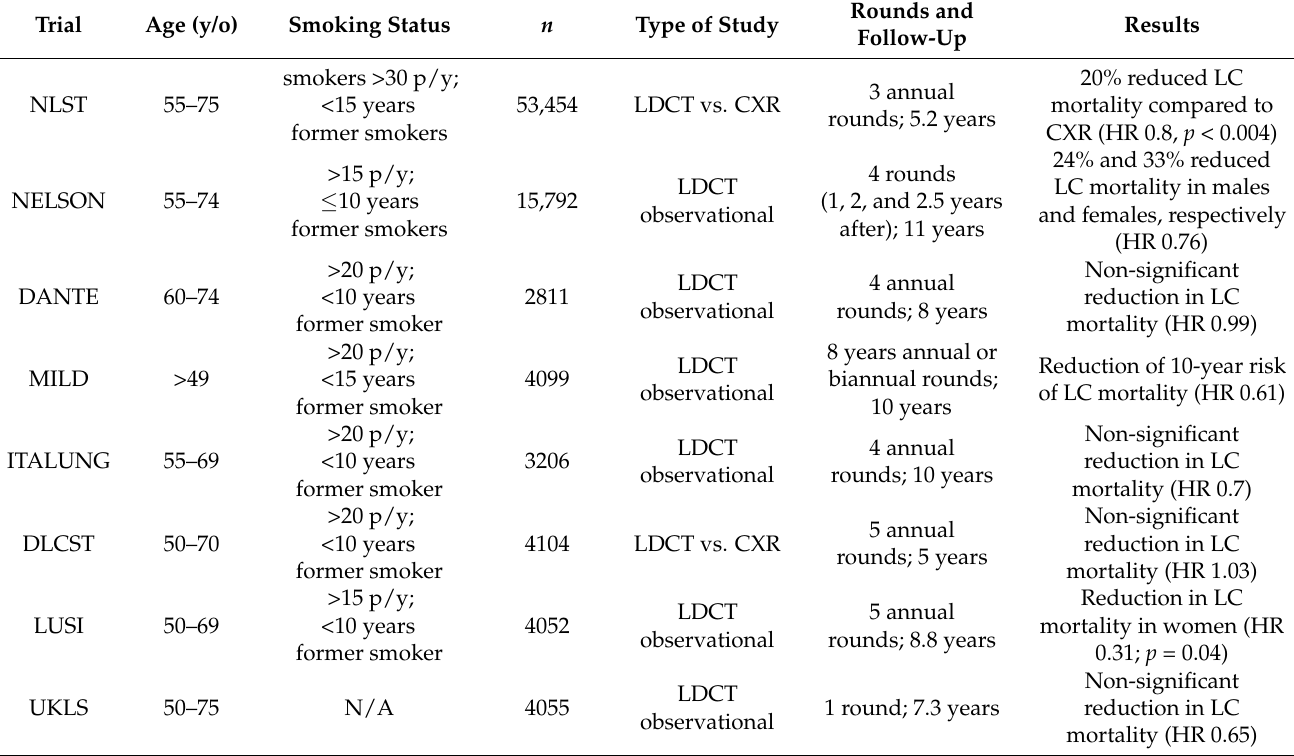
Table 1. Eligibility criteria, number of participants, type of study, and results of the main randomized clinical trials on lung cancer screening. NLST and NELSON trials are the only powered studies. Pooled results of MILD and DANTE show 17% LC mortality reduction (HR